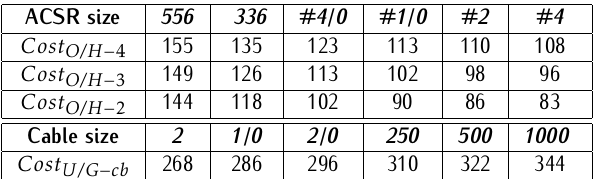
Table 1. Feeder standard replacement costs ($000/km)